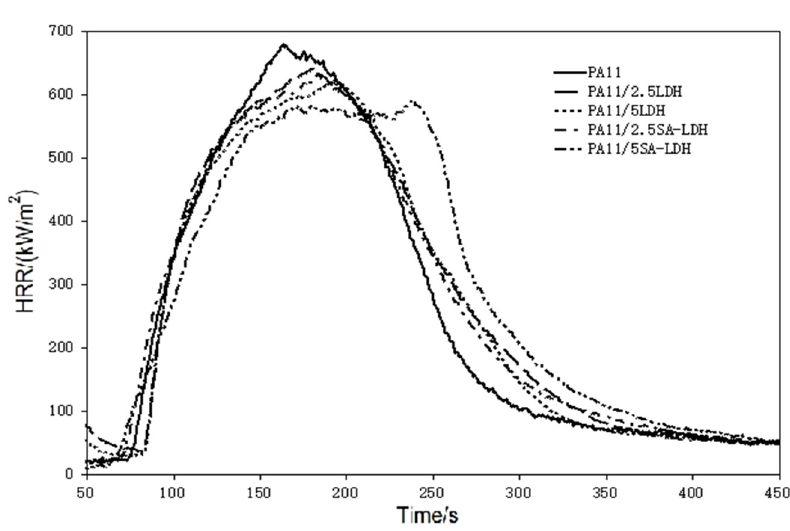
Figure 5. HRR curves of PA11 and its composites.